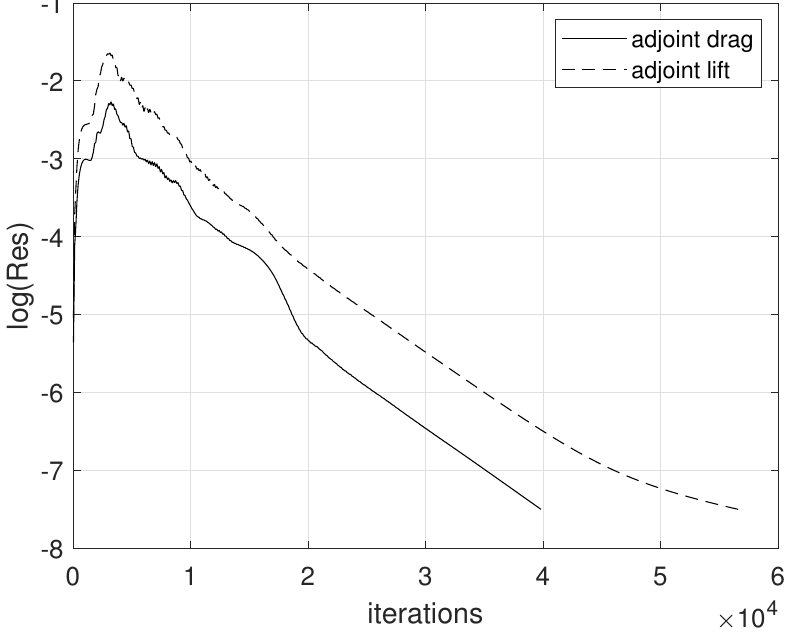
Figure 13. Convergence of the adjoint for the baseline aerofoil geometry.